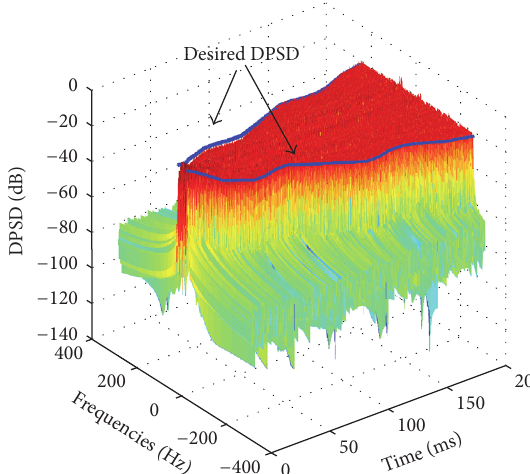
Figure 6: Time-variant DPSD of generated fading channel. The dotted line denotes the outline of desired Gaussian-shaped DPSD in Figure 3.